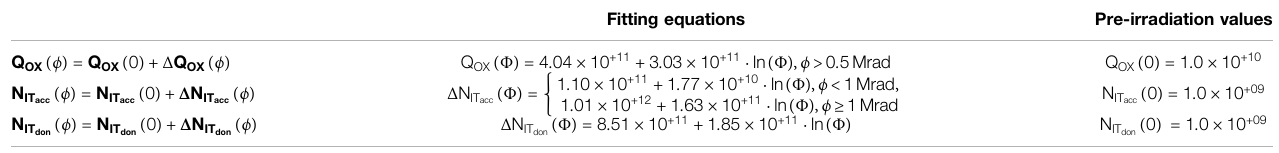
TABLE 3 | Fitting equations and pre-irradiation values for “ Perugia 2019 Surface ” modeling IFX eight ″ silicon devices: oxide charge QOX (cm − 2 ), acceptor interface trap states NITacc (cm − 2 ), donor interface trap states NITdon (cm − 2 ). Fitting equations Pre-irradiation values